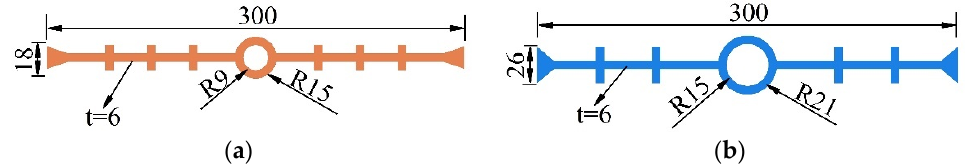
Figure 18 . Dimensions of waterstops II and III (unit: mm). ( a ) waterstop II. ( b ) waterstop III.